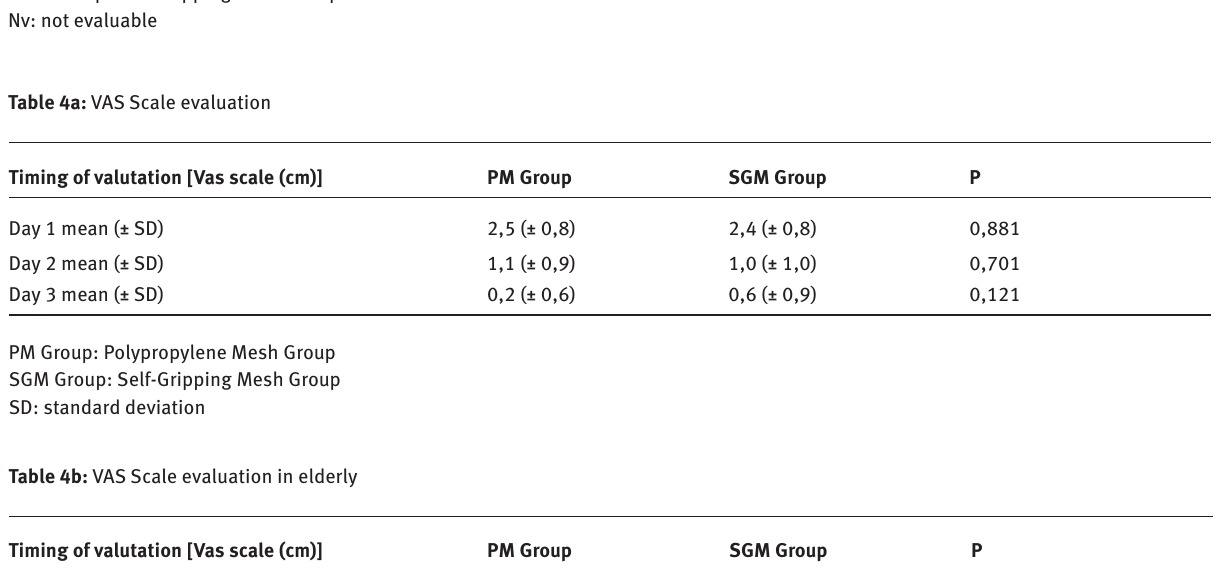
Timing of valutation [Vas scale (cm)] PM